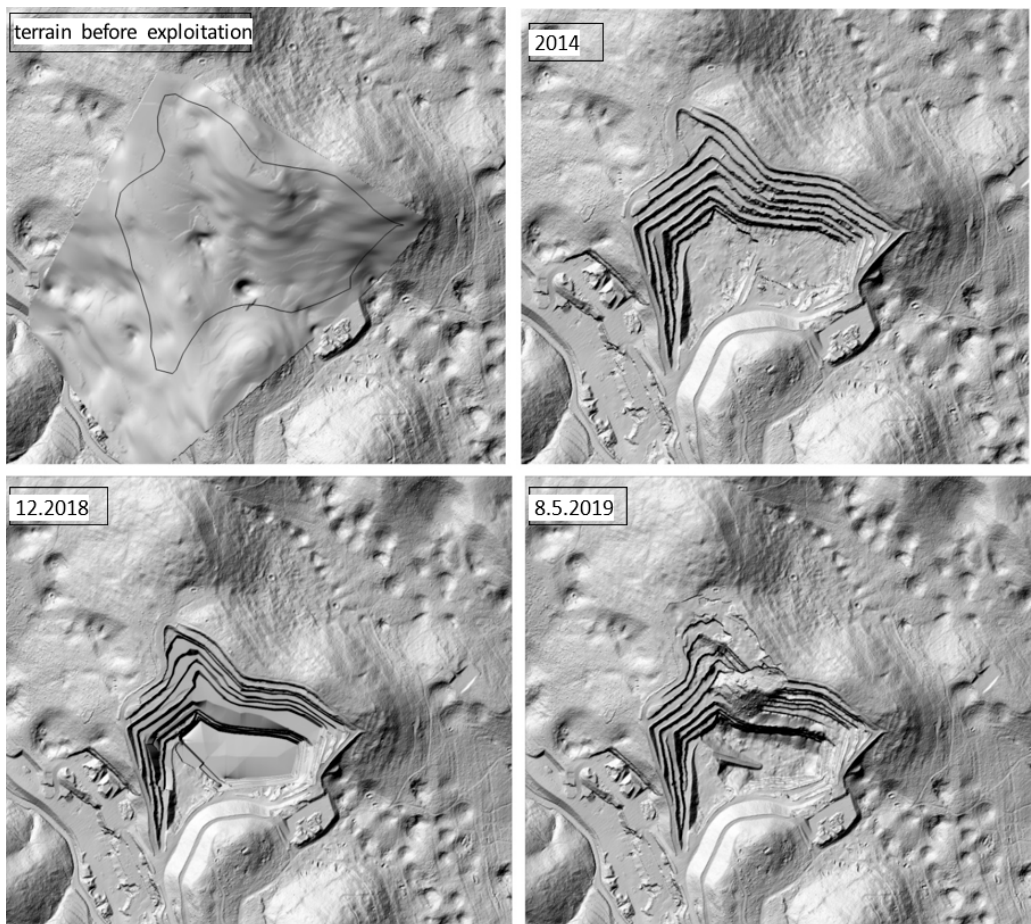
Figure 5. Shaded models of quarry relief in the four phases of the Laže 1 quarry operation.